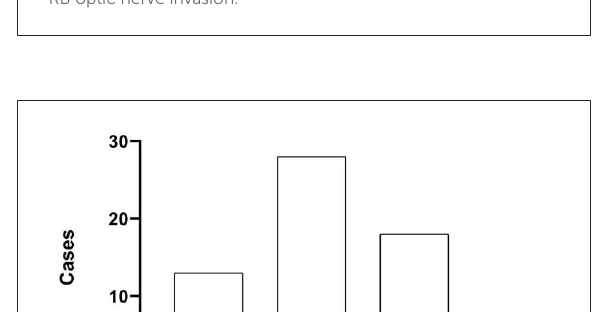
FIGURE7 Rate of complications by state in of 59 children with RB optic nerve